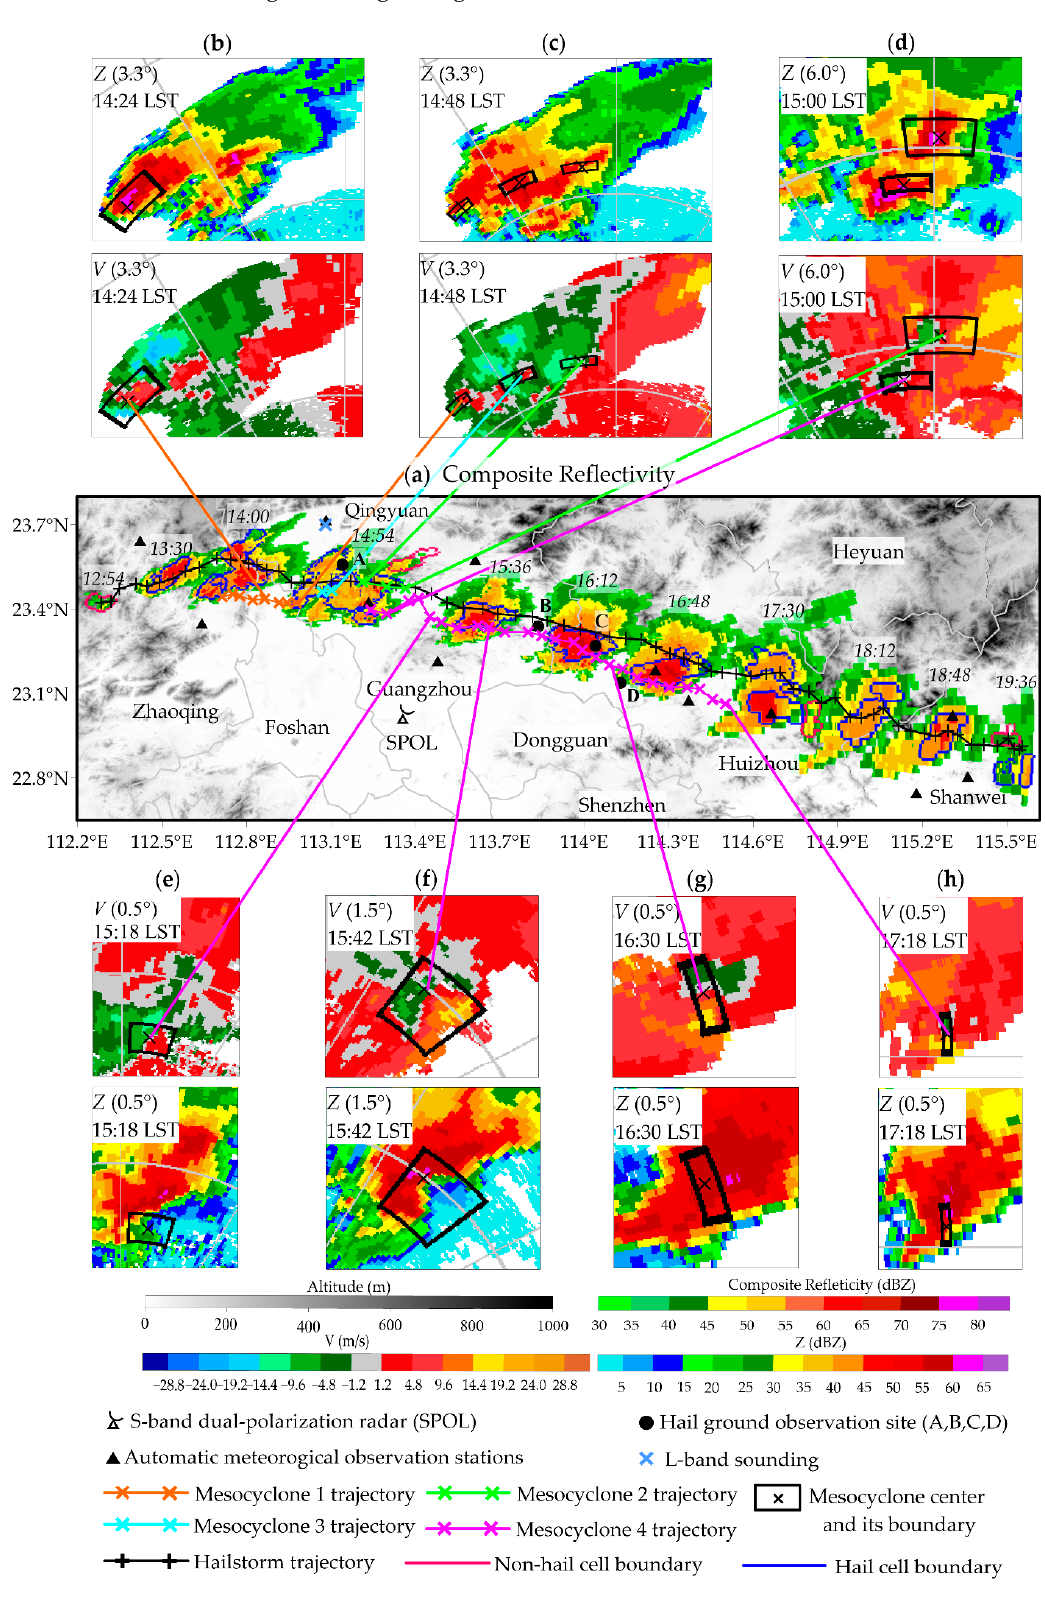
Figure 8. Temporal evolution of ( a ) composite reflectivity echoes of a hailstorm and ( b – h ) four